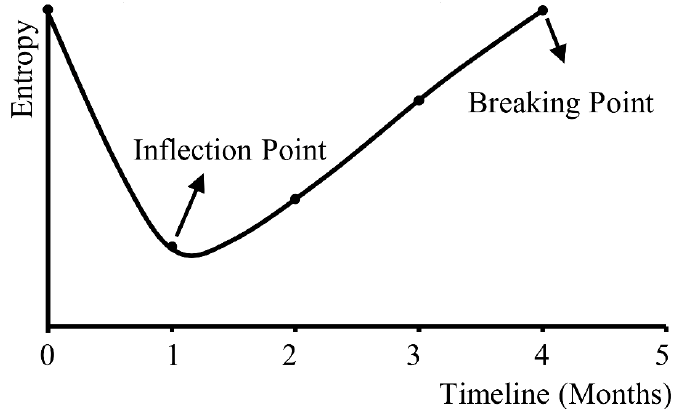
Figure 8: Variation in the entropy of the employees’ satisfaction with protection measures according to the perceptions of an employee for the Worst-case scenario